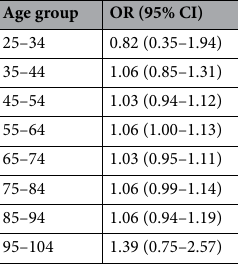
Table 6. Results of the sensitivity analyses using detailed age strata, expressed as odds ratios and 95% confidence intervals.